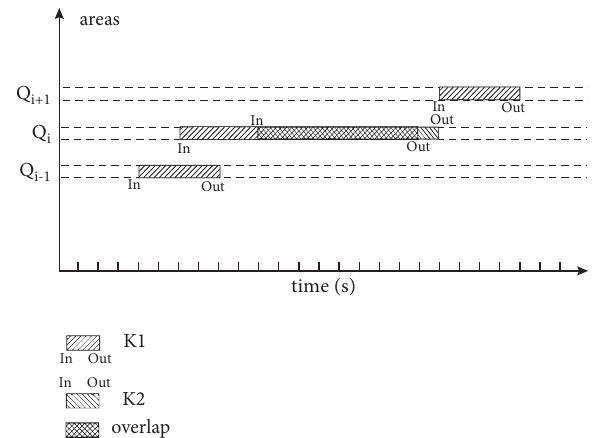
Figure 11: Update time window for rear-end conflict.